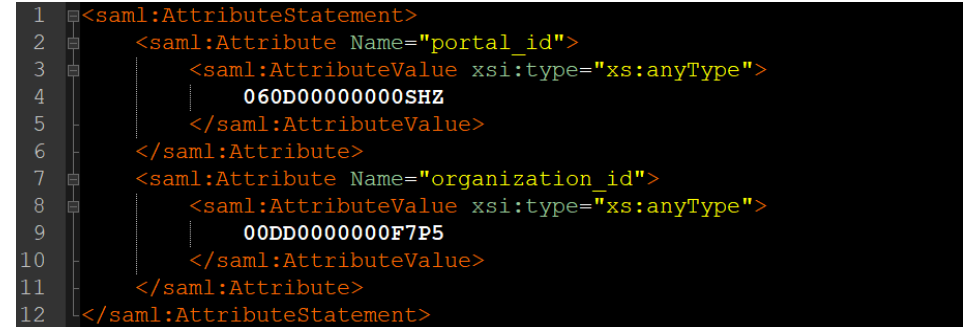
Figure 8. SAML code for information access.